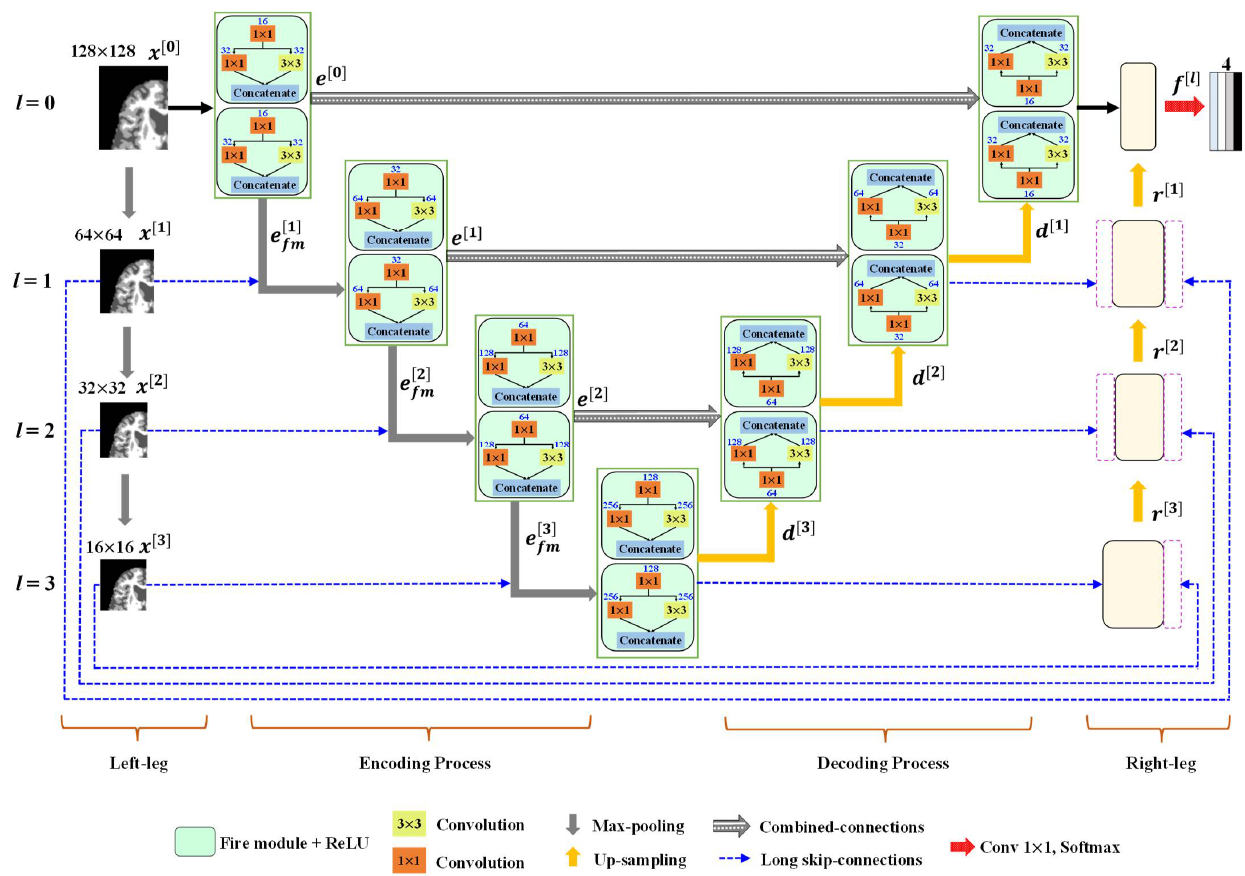
Figure 3. The overall architecture of the proposed SM-SegNet model. The fire modules are shown as solid boxes, with the set of feature maps indicated on the top of each box.